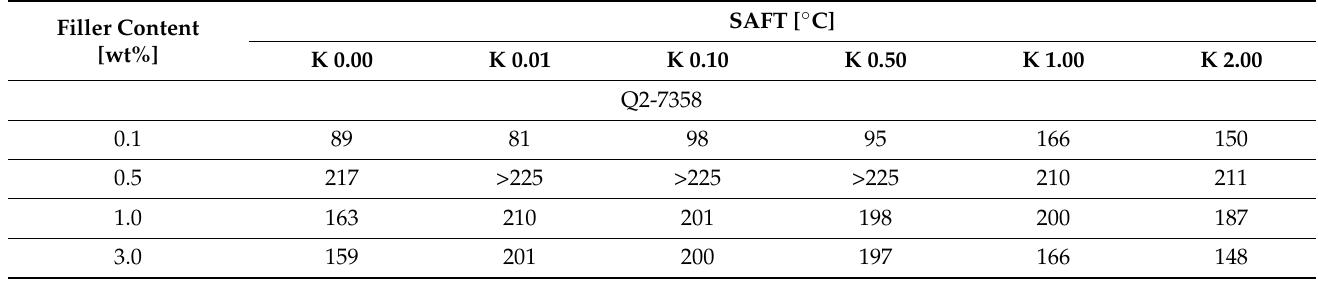
Table 7. The maximal working temperature of silicon adhesives with